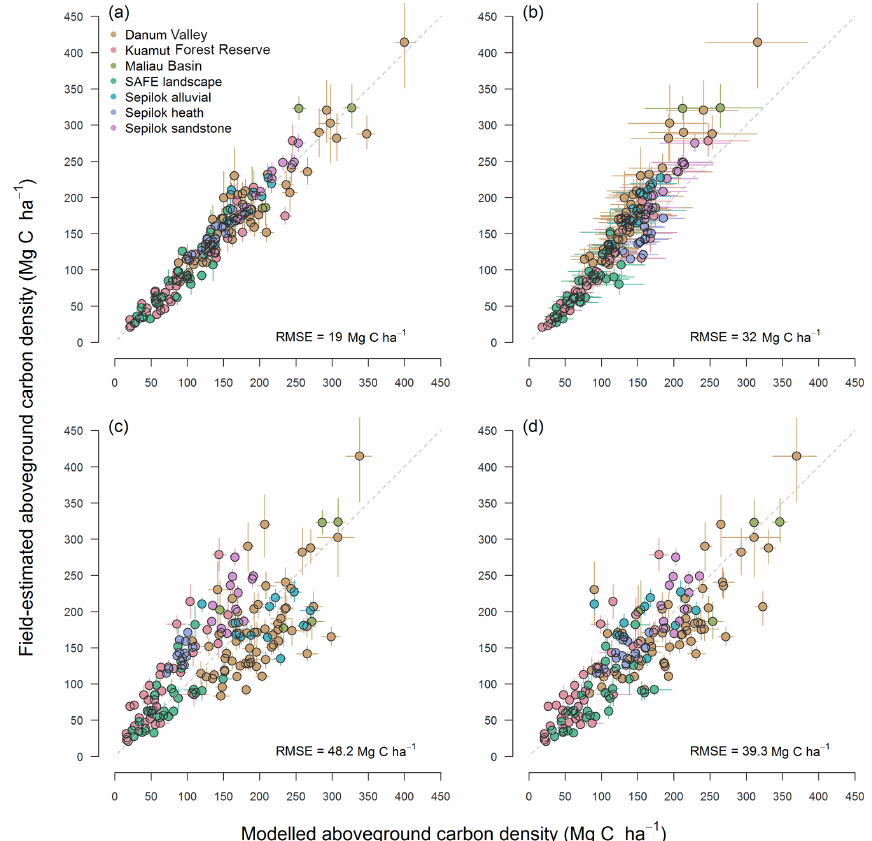
Figure 2. Relationship between field-estimated and modelled aboveground carbon density (ACD). Panel (a) shows the fit of the regionally calibrated ACD model (Eq. 8 in Sect. 3), which incorporates field-estimated basal area (BA) and wood density (WD), while panel (b) cor- responds to Asner and Mascaro’s (2014) general ACD model (Eq. 1 in Sect. 1). Panels (c) – (d) illustrate the predictive accuracy of the regionally calibrated ACD model when field-measured BA and WD values are replaced with estimates derived from airborne laser scanning. In panel (c) BA and WD were estimated from top-of-canopy height (TCH) using Eqs. (9) and (11), respectively. In contrast, ACD estimates in panel (d) were obtained by modelling BA as a function of both TCH and canopy cover at 20m aboveground following Eq. (10). In all panels, predicted ACD values are based on leave-one-out cross validation. Dashed lines correspond to a 1 : 1 relationship. Error bars are standard deviations and the RMSE of each comparison is printed in the bottom right-hand corner of the